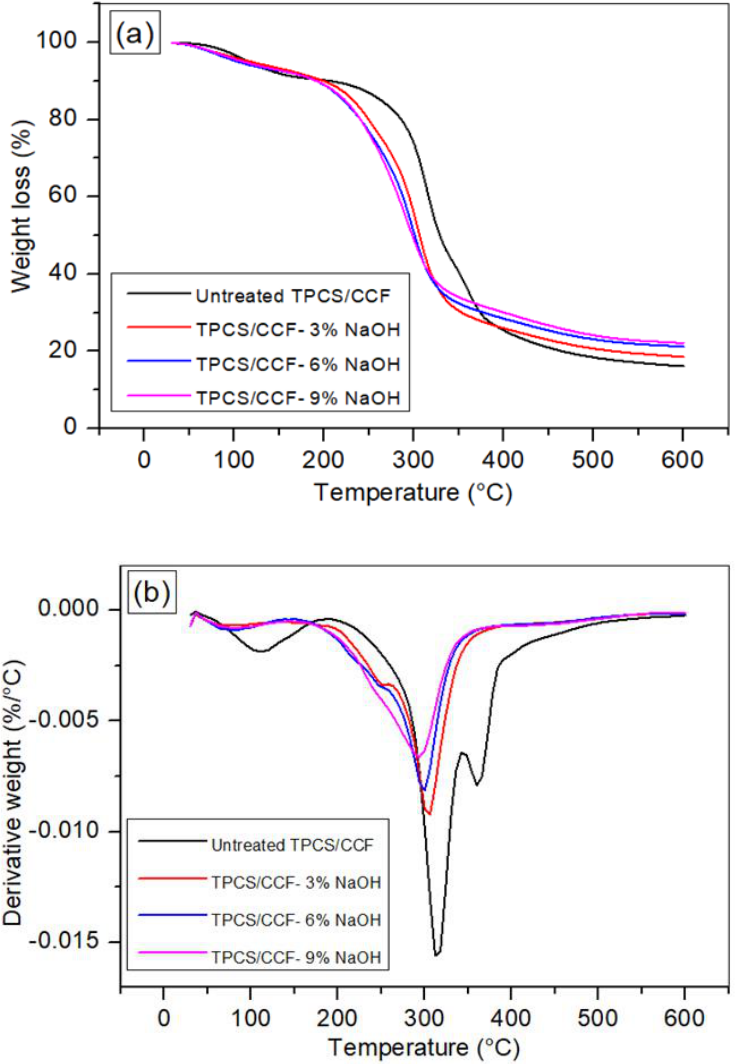
Figure 6. ( a ) TGA and ( b ) DTG of the untreated and NaOH-treated TPCS/PW/CCF